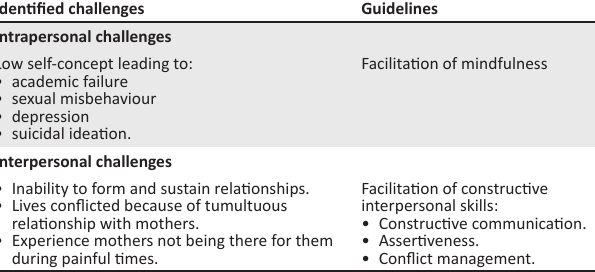
TABLE 1: Identified challenges and guidelines to address